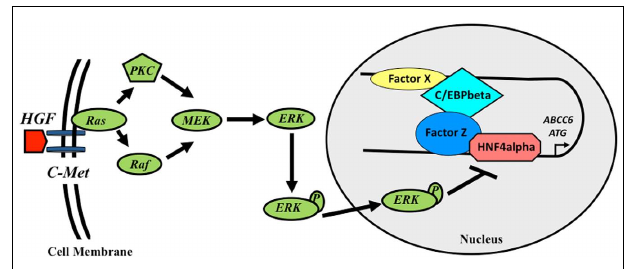
FIGURE 2 | Schematic model of the transcriptional regulation of the humanABCC6 gene. Growth factors inhibit the expression of ABCC6 via the activation of ERK1/2 cascade, which reduces HNF4 α binding to the promoter. In the intron, a transcriptional activator sequence binds C/EBP β and another hypothetical protein (Factor X).These proteins interact with a complex formed by HNF4 α and another factor (Y) binding the promoter, activating the transcription of the